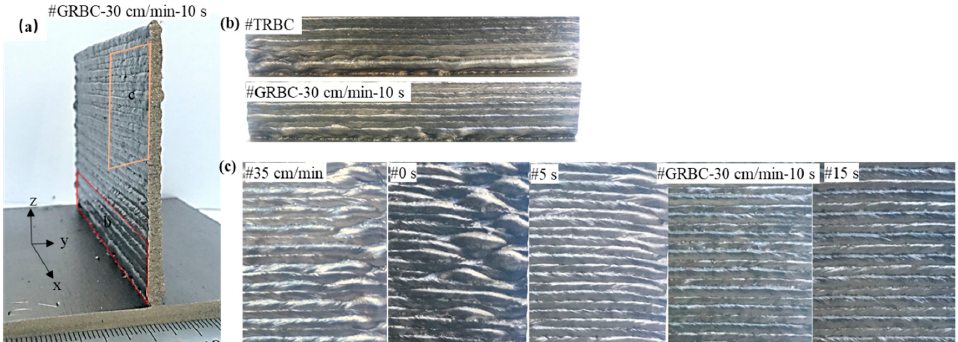
Figure 5. Profile morphologies of deposited wall samples prepared using different parameters: ( a ) Sample #GRBC-30 cm/min-10 s profile; ( b, c ) bottom and top-right parts of different samples, respectively (the parts in ( b ) correspond to the bottom region of ( a ), whereas the parts in ( c ) correspond to the top-right region of ( a )). (TRBC and GRBC represent transient and gradual reduction of bottom current, respectively).